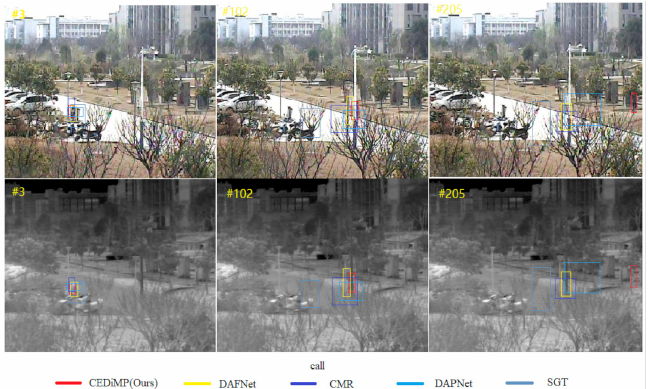
Figure 9. Qualitative comparison results on call image sequences in